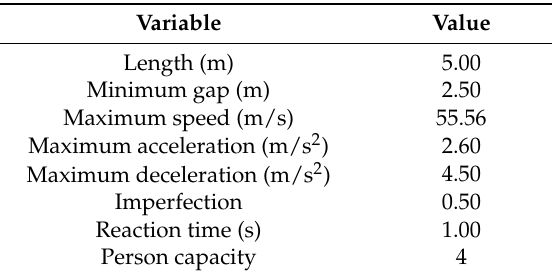
Figure 6 . Vehicle queues ( a ) and pollution behavior ( b ) in an open-loop simulation. 3.4. Consensus-Based Control Applied to the Test Scenario In this subsection, the simulation of the cooperative control system in the test scenario is described. The scenario is composed of four interconnected TLCs . The system components and the interaction between them are represented in Figure 7. Figure 7. TLCs interaction scheme.